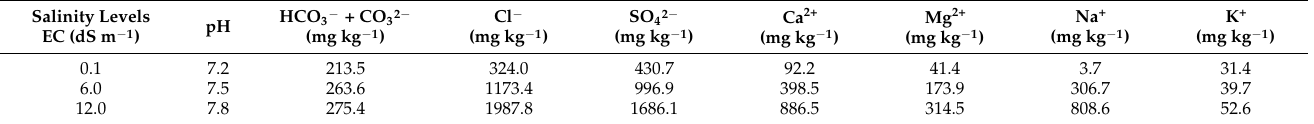
Table 1. Chemical properties of the soil under different salinity